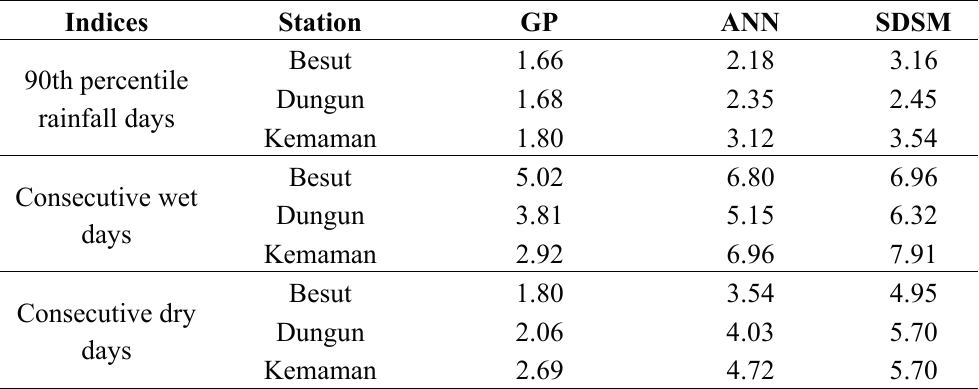
Table 7 . The RMSE in downscaled seasonal extreme indices using GP, the ANN and the SDSM during model